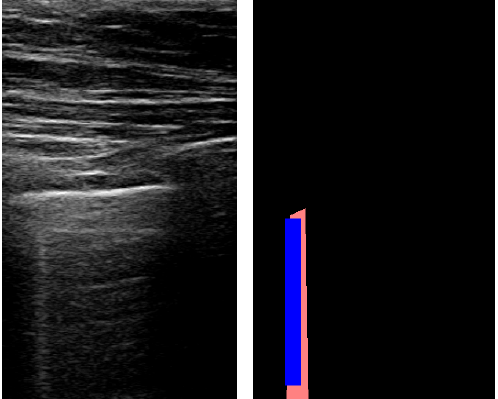
Figure 9. An example of B-line segmentation using Fourier transform (red: true mask; blue: pre- dicted